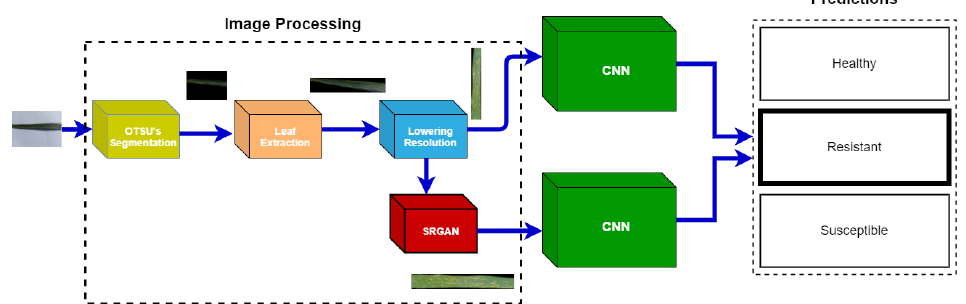
Figure 1. Complete pipeline of the methodology used in this